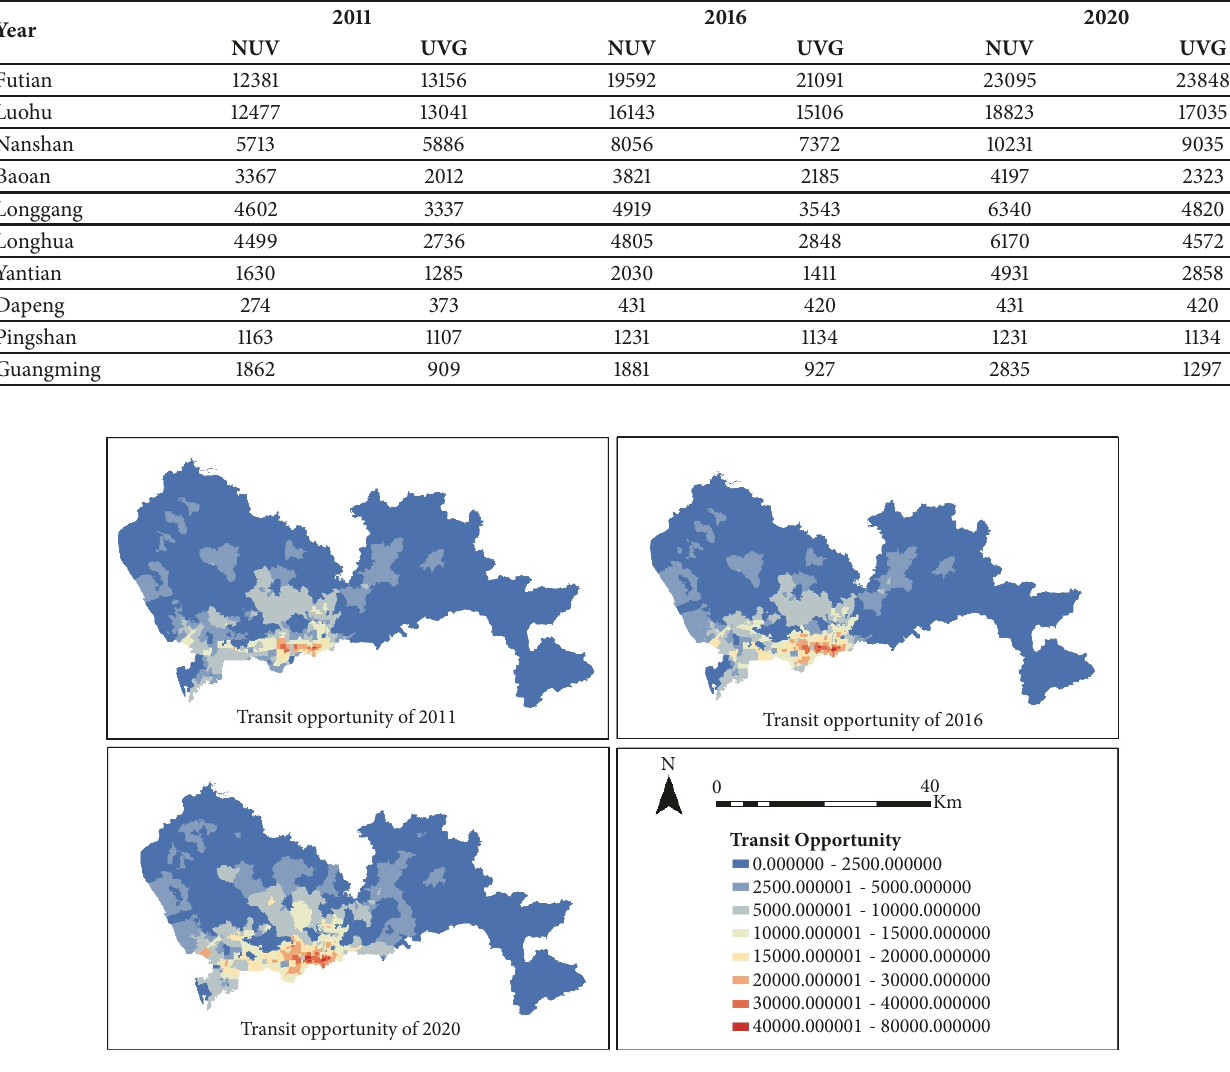
Table 3: Transit opportunity of two groups in each region.